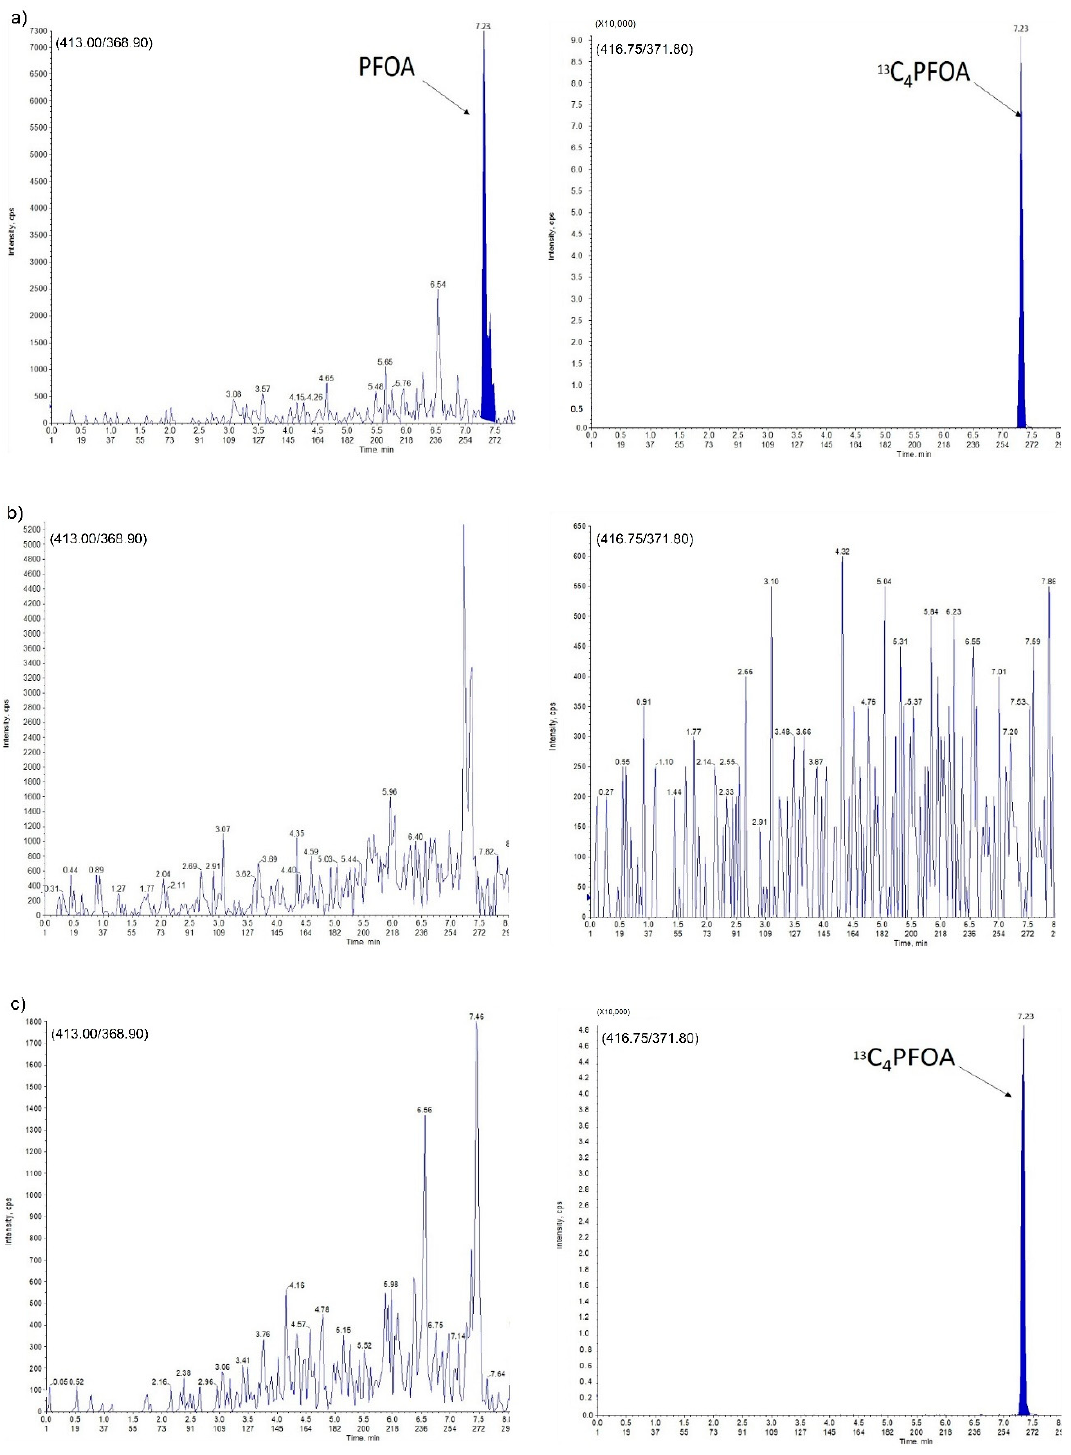
Figure 4. Perfluorooctanoic Acid (PFOA) in egg yolk sample: ( a ) LLOQ; ( b ) double blank sample; ( c ) zero blank sample.